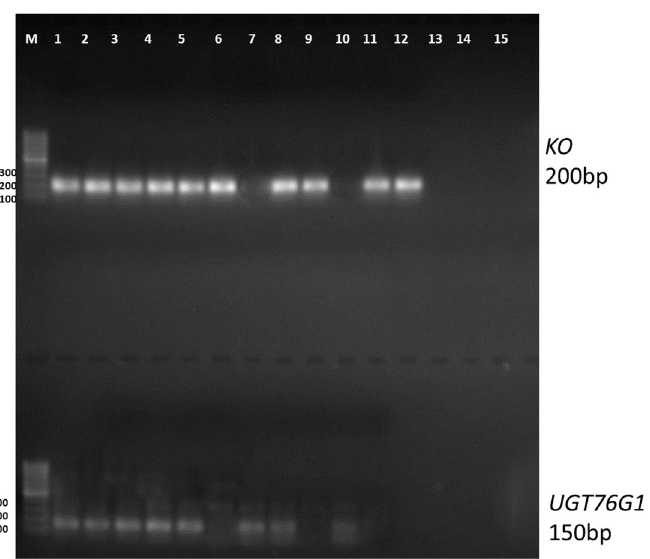
Fig 3. Transformation confirmation by visualizing the desired amplicons on agrose gel